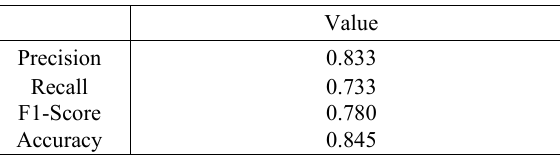
Table 4. Evaluation